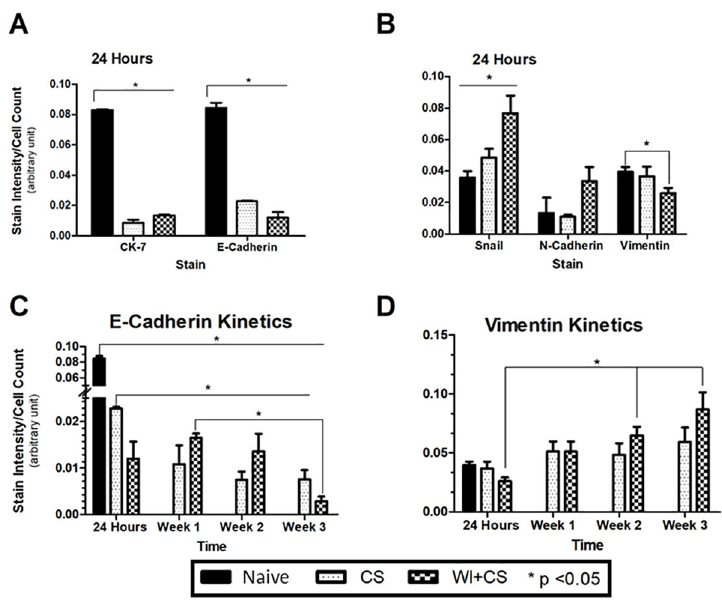
Fig 4. Epithelial protein expression profiles on cholangiocytes. Immunocytochemical expression of cholangiocyte CK7 and E-Cadherin (epithelial cell markers, panel A) and SNAIL, E-Cadherin, and Vimentin (mesenchymal markers, panel B) 24 hours after sham ischemia (Naive controls), after 24 hours after cold storage (CS), and after both warm ischemia (60 minutes) and CS (WI+CS). The kinetics of expression of E-Cadherin (Panel C) and Vimentin (Panel D) are also shown for all three groups of cholangiocytes. � P < 0.05, data expressed as the sample mean +/- SD from 5 independent